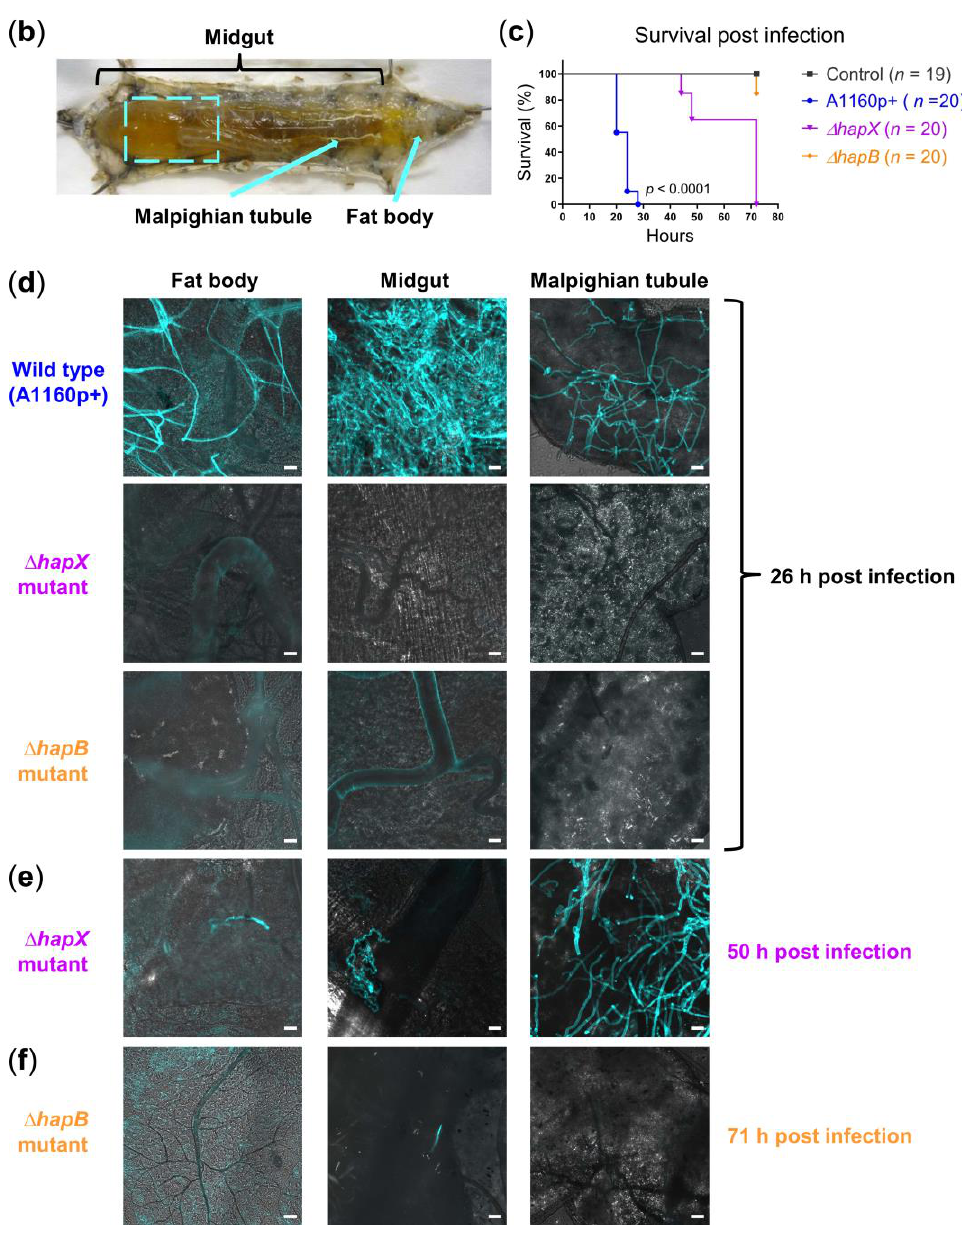
Figure 1. Comparison of fungal burden in silkworms infected with different A. fumigatus strains. ( a ) Illustration of experimental setup; CW: Calcofluor white; ( b ) anatomy of silkworm: Dashed square indicates the area of midgut taken for microscopy; arrows indicate the Malpighian tubule, and the area where fat body was extracted; ( c ) survival of silkworms infected with 2 × 10 5 spores of the wild type (WT) strain A1160p+, ΔhapX or ΔhapB mutant; silkworms in the control group were injected with 50 µL NaCl-Tween; n : Number of silkworms per group; Kaplan-Meier survival curves were compared using the log-rank test; pairwise comparisons were performed between the A1160p+ and ∆hapX groups, as well as between the A1160p+ and ∆hapB groups; both comparisons show p -values < 0.0001; ( d ) merged images (calcofluor white in turquoise + brightfield) show fungal burden in different organs of WT-infected silkworms at 26 h post infection, while hyphae of the ∆ hapX and ∆ hapB mutants were detectable in the organ(s) at 50 h ( e ) and 71 h ( f ) post infection, respectively; scale bars represent 20 µ